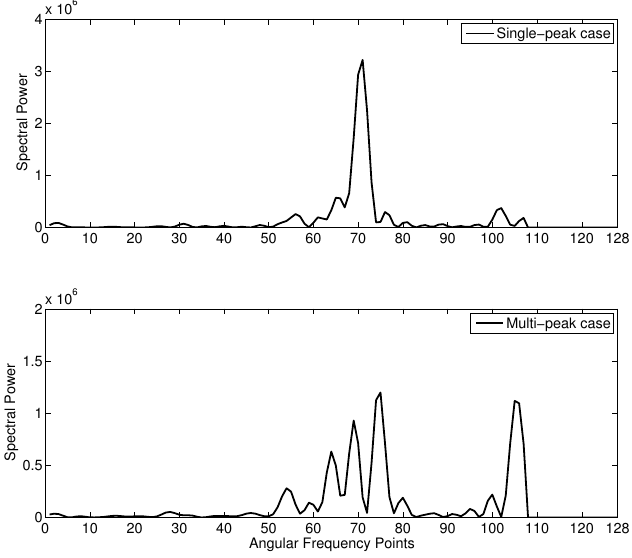
Figure 2. The power distribution at different frequency points for two adjacent wavenumber vectors. The upper sub-plot has only one prominent peak, and the corresponding frequency is retained as an element in the dispersion shell. The lower sub-plot shows multiple peaks that are noise contaminated and is thus